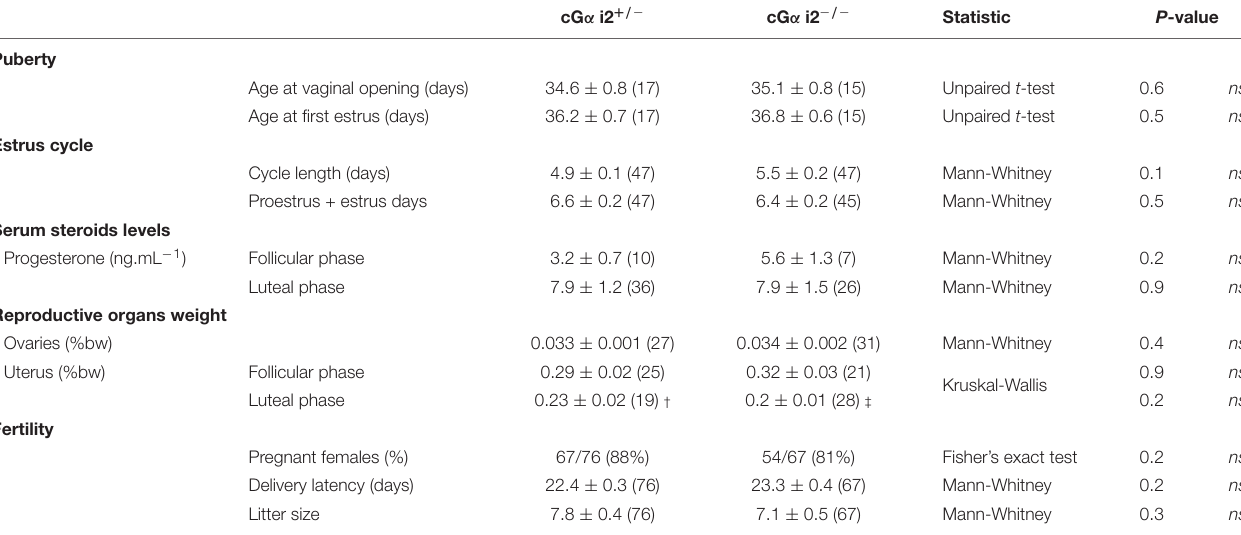
TABLE 1 | cG α i2 − / − females show normal reproductive